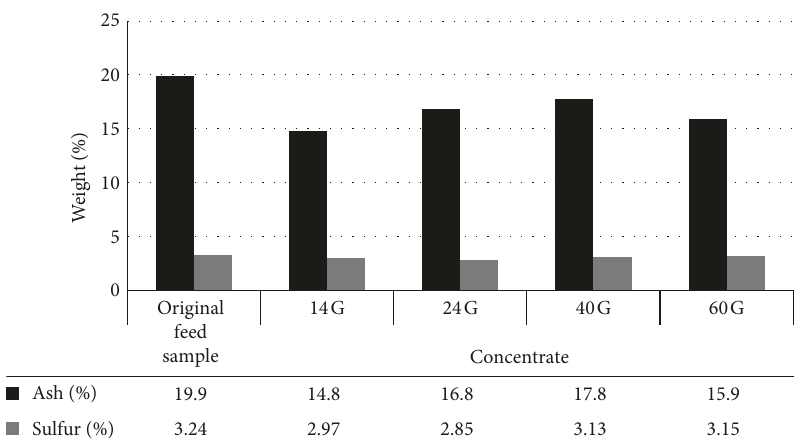
Figure 6: Sample-C1 Knelson gravity ash % and sulfur % analysis chart (